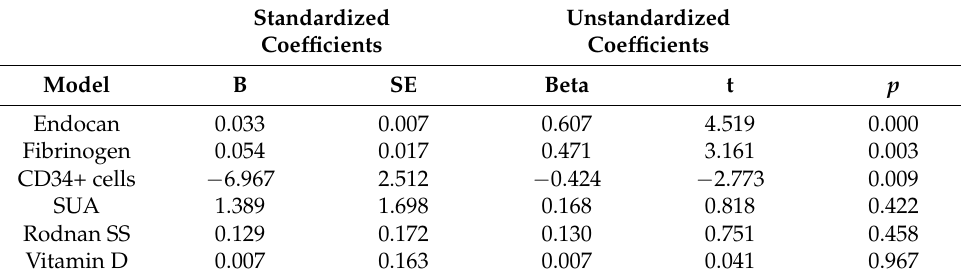
Table 5. Linear regression model.